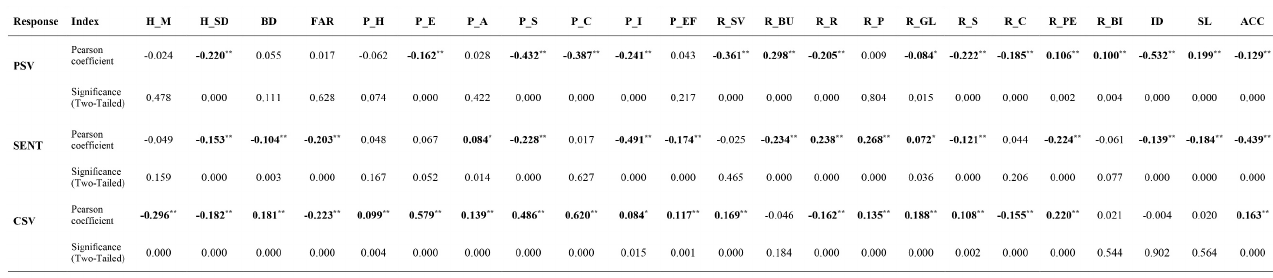
Figure A1. Two-tailed statistical significance test Figure A1. Two‑tailed statistical significance